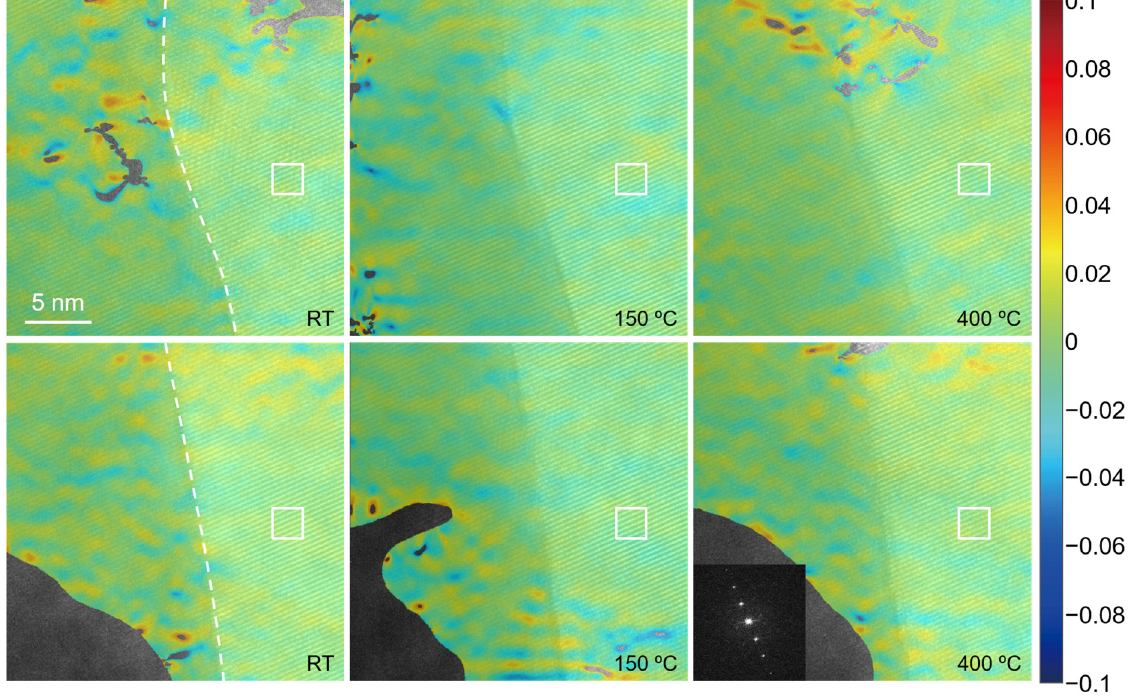
Figure 10. Strain distribution near the TGO/BC interface at different temperatures.